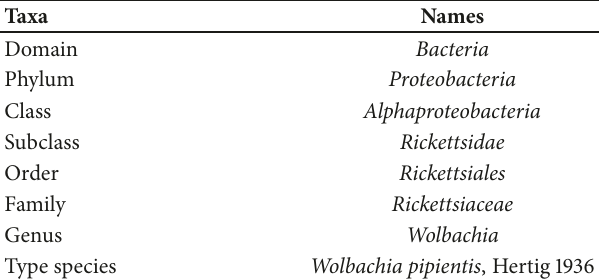
Table 1: Taxonomic classification of